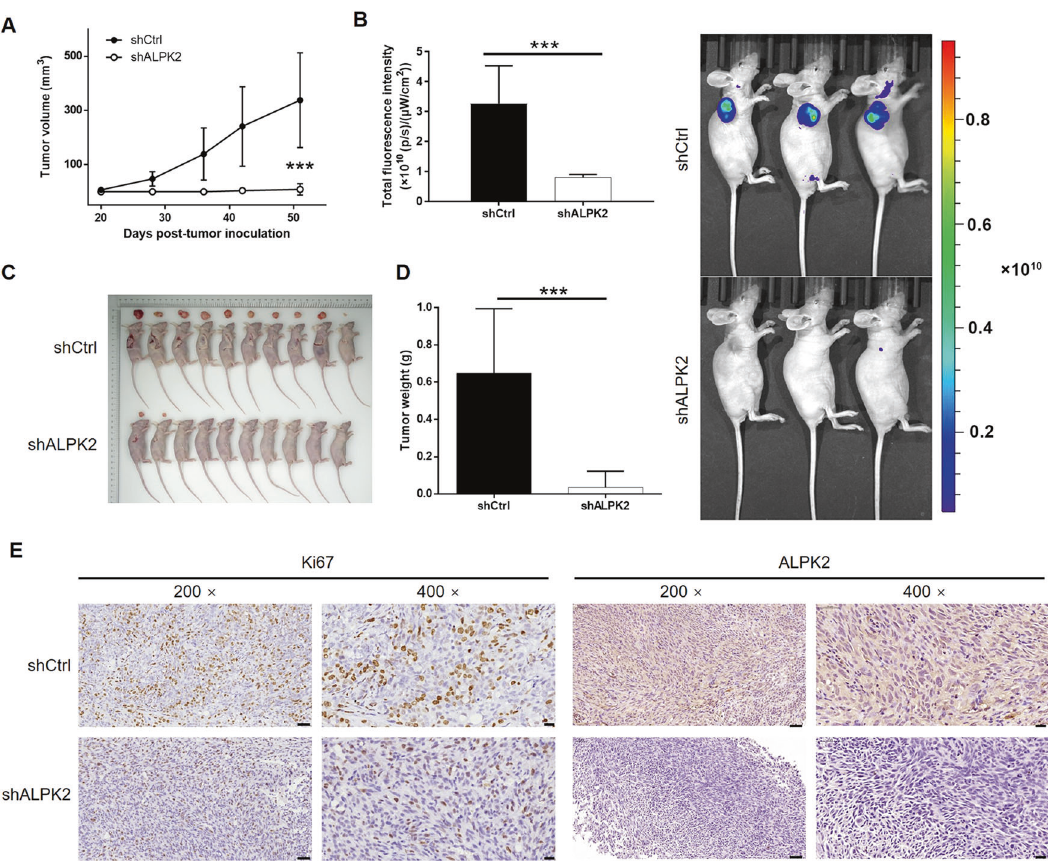
Fig. 3 ALPK2 knockdown inhibited bladder cancer development in vivo. A Twenty days of post-injection of T24 cells with or without ALPK2 knockdown, the volume of tumors formed in mice was measured and calculated at indicated time intervals. B In vivo imaging was performed to evaluate the tumor burden in mice of shALPK2 and shCtrl groups at day 22 of post-tumor-inoculation. The fl uorescence intensity was scanned and used as a representation of tumor burden in mice of shALPK2 and shCtrl groups. C , D Mice were sacri fi ced at day 22 of post- injection, and the tumors were removed for collecting photos ( C ) and weighing ( D ). E The expression of Ki67 and ALPK2 in tumors removed from mice of both groups was detected by IHC analysis (scale bar = 50 μ m in 200 magni fi cation, scale bar = 20 μ m in 400 magni fi cation). Data were shown as mean ± SD. *** P <